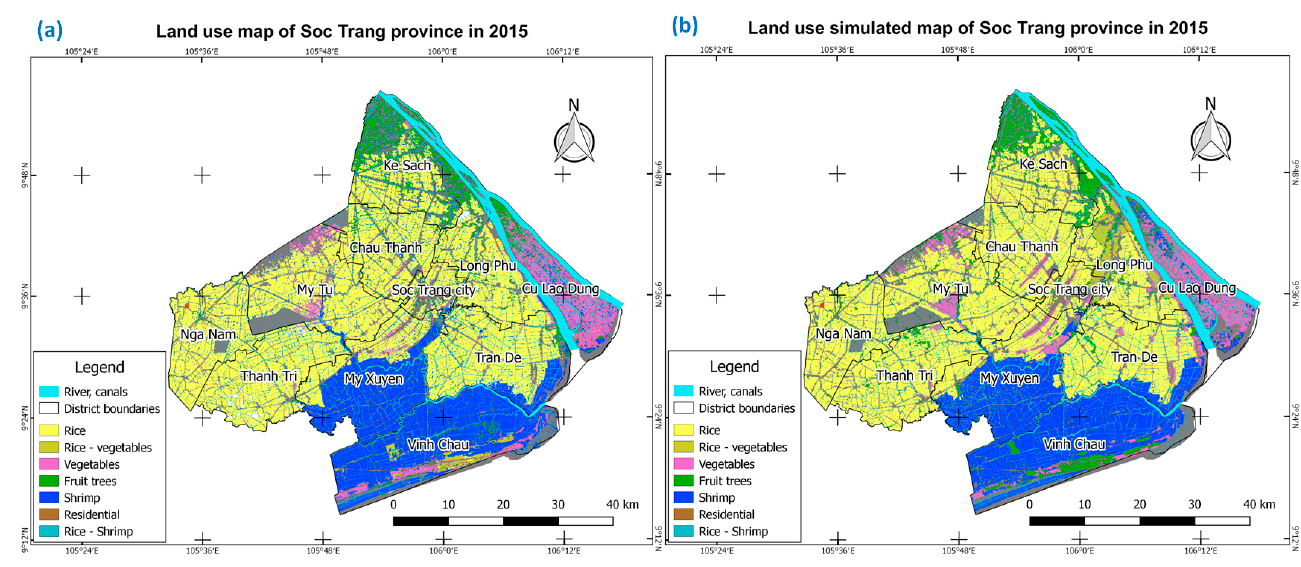
Figure 7. Simulated land-use map that was verified with a land-use map from 2015. ( a ) Land-use map in 2015; ( b ) Simulated land-use map in 2015.